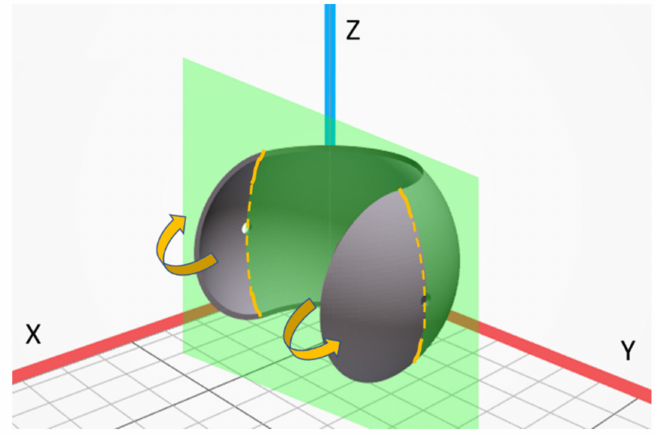
Figure 6. Fracture surface of printed parts for metallographic testing; green plane—fracture plane, arrows—direction of loading, continuous lines—pre-cracks, dashed lines—fracture surfaces for SEM studies.